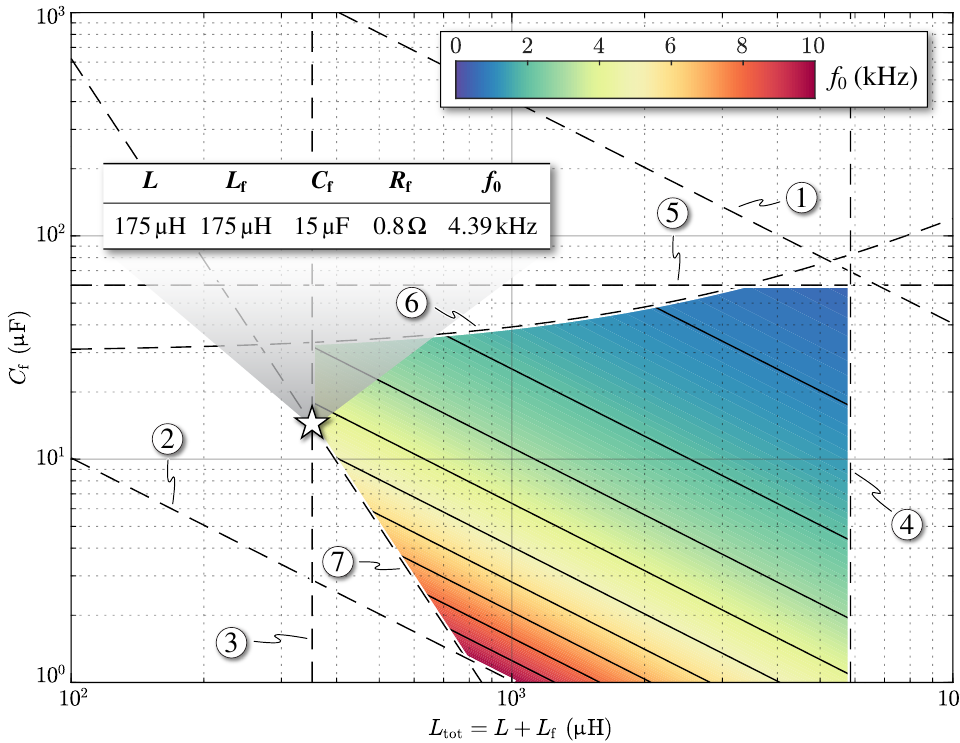
Figure 10. LCL filter design space in the ( C f , L tot ) logarithmic plane. Constraints 1 – 7 bound the feasible design region. The design with minimum total inductance is selected and the parameter values of the LCL filter are reported in the highlighted table.